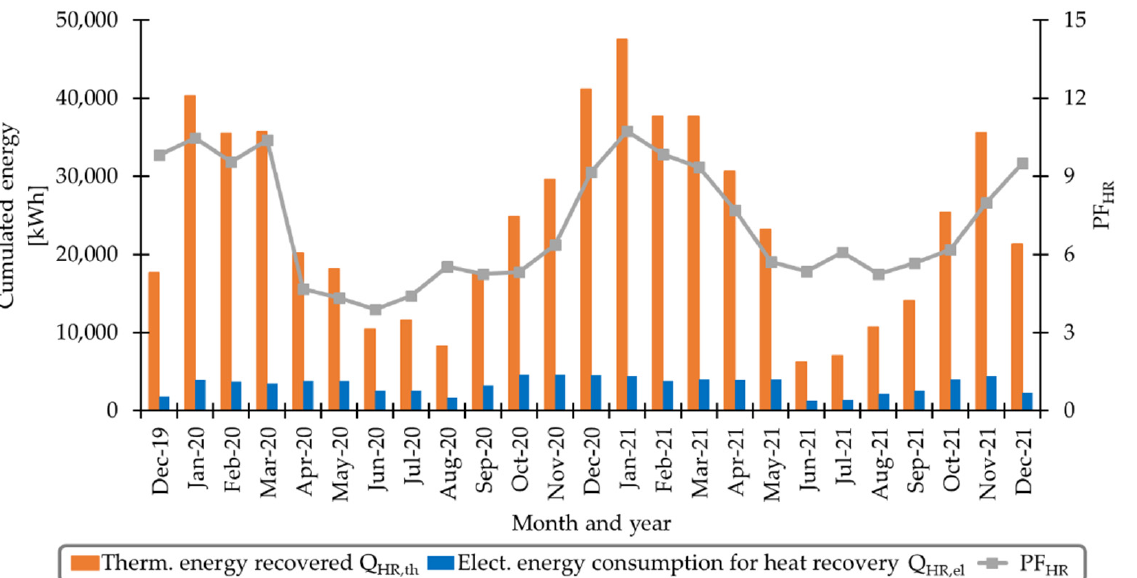
Figure 8. Course of the cumulated thermal energy recovered Q HR,th [kWh th ], the cumulated electrical energy consumption for the heat recovery Q HR,el [kWh el ], and the corresponding PF HR,heating of the two heat exchangers over the various trial months (cumulated or mean values, respectively).